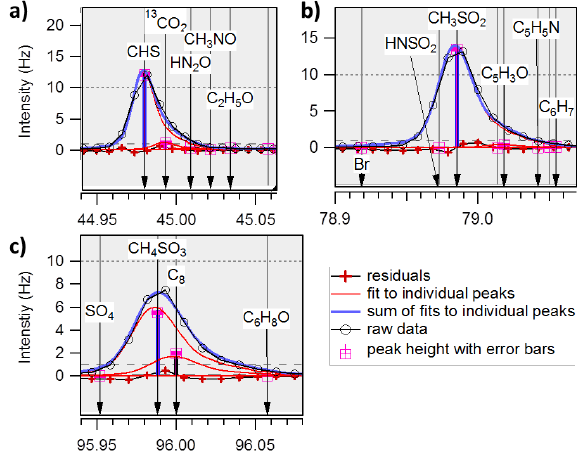
Fig. 8. Selection of high-resolution marker ion fragments for methanesulfonic acid OA in the difference spectrum.